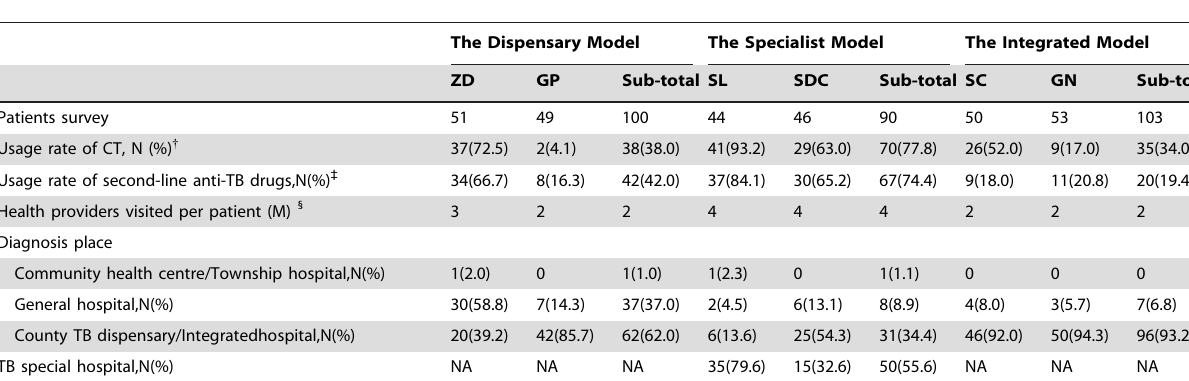
Table 3. Health care seeking behavior of TB patients in the three models.